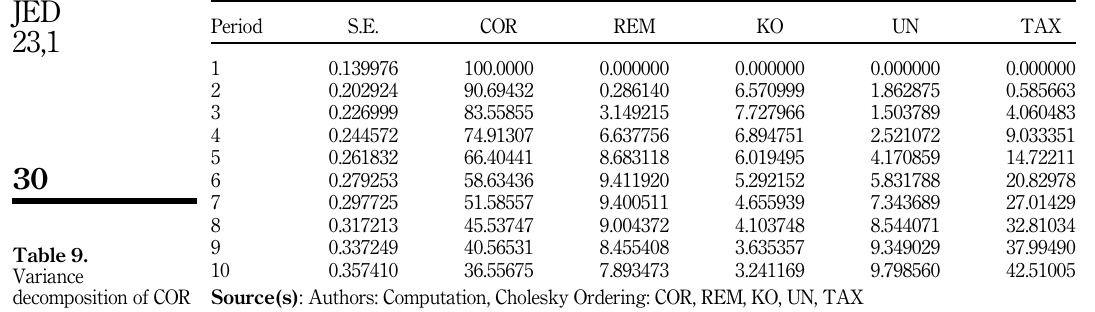
decomposition of